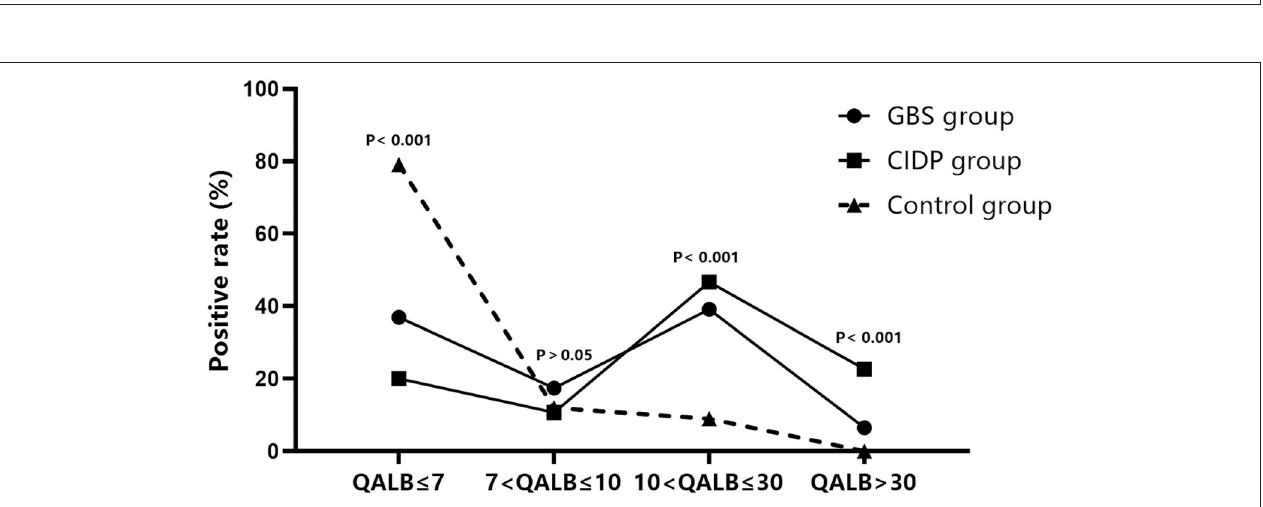
FIGURE 2 | QALB stratification analysis in the GBS, CIDP and control groups. QALB stratification analysis showed that the ranges of 10 < QALB ≤ 30 were dominant in the GBS and CIDP groups, and the positive rate of CIDP was higher than that of GBS. Furthermore, a QALB ≤ 7 was dominant in the control group, and a QALB > 30 was dominant in the CIDP group.